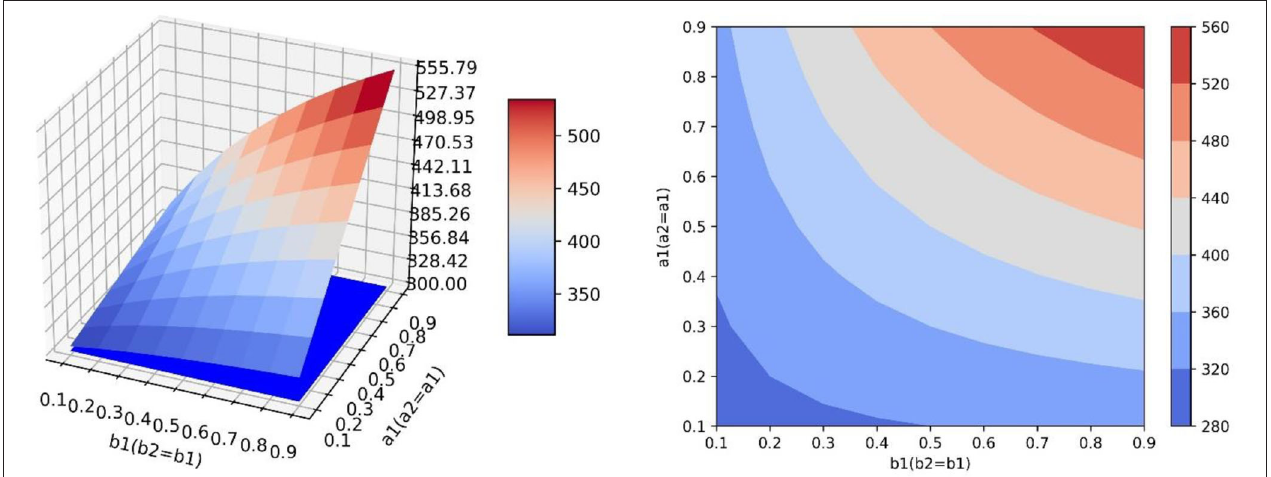
FIGURE 6 | In the scene of simulation 1, the value of positive emotion at the equilibrium point: surface graph and surface projection.